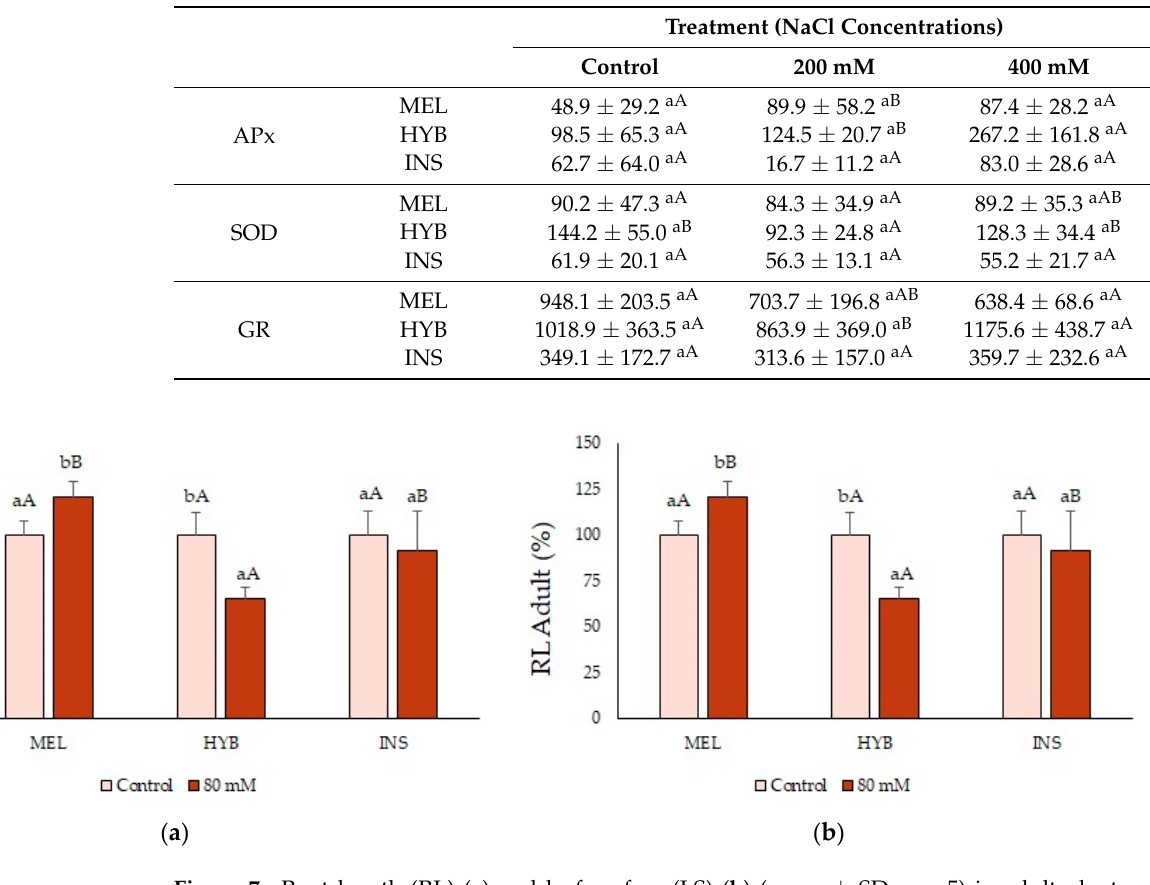
Table 5. Superoxide dismutase (SOD), ascorbate peroxidase (APx) and glutathione reductase (GR) spe- cific activities (units mg − 1 protein) (mean ± SD; n = 5) in Solanum melongena (MEL), Solanum insanum (INS) and their hybrid (HYB) in the conditions tested (control, 200 mM and 400 mM of NaCl). Different lowercase letters within the same row indicate statistically significant differences between treatments, and different uppercase letters within the same column indicate statistically significant differences be- tween genotypes for each measured compound ( p < 0.05), according to the Student–Newman–Keuls multiple range test.